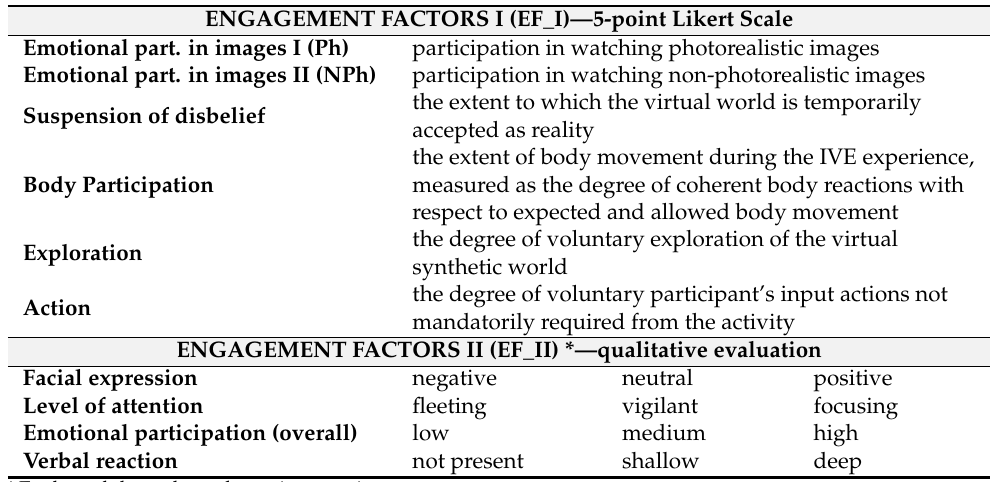
Table 2. The adopted engagement evaluation